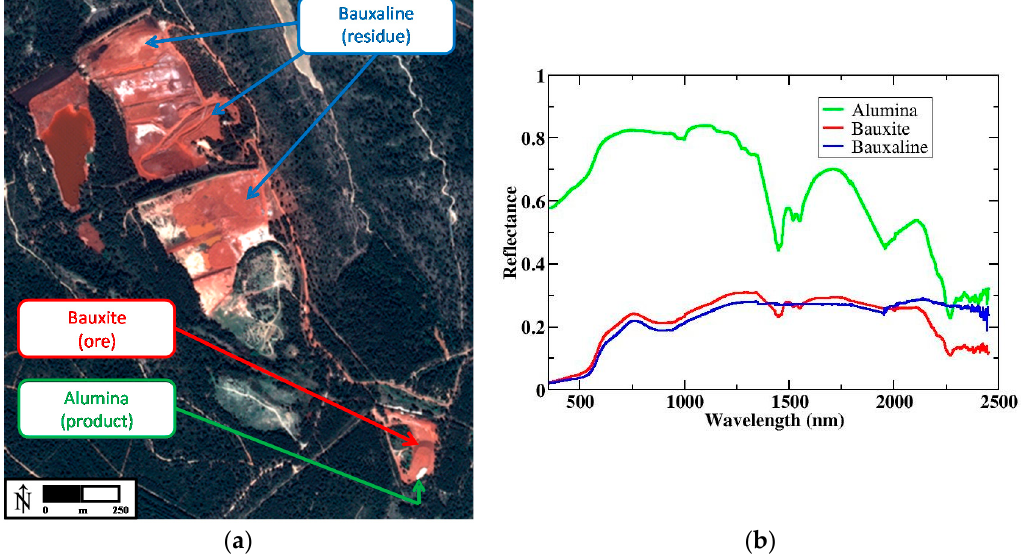
Figure 2. ( a ) Mangegarri waste storage area (Altéo); and ( b ) field spectra of the main materials. Mangegarri area extension is about 0.5 × 1.5 km 2 . Mangegarri area extension is about 0.5 × 1.5 km 2